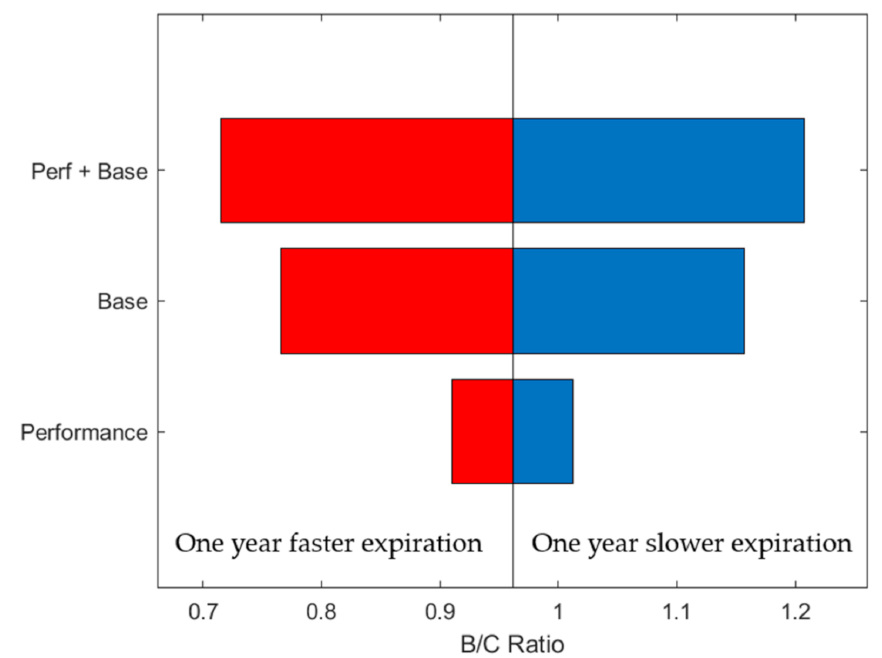
Figure 9. B/C ratio sensitivity owing to modification of benefit period